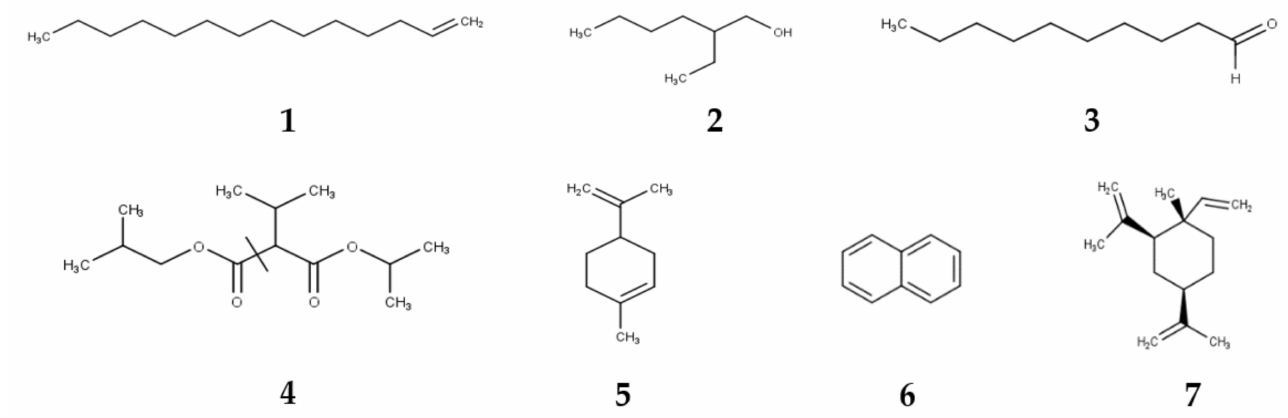
Figure 1. Major volatile compounds found in bryophytes. Abbreviations: 1-tetradecene ( 1 ), 2-ethyl- 1-hexanol ( 2 ), decanal ( 3 ), pentanoic acid, 2,2,4-trimethyl-3-carboxyisopropyl, isobutyl ester ( 4 ), limonene ( 5 ), naphthalene ( 6 ), β -elemene ( 7 ).